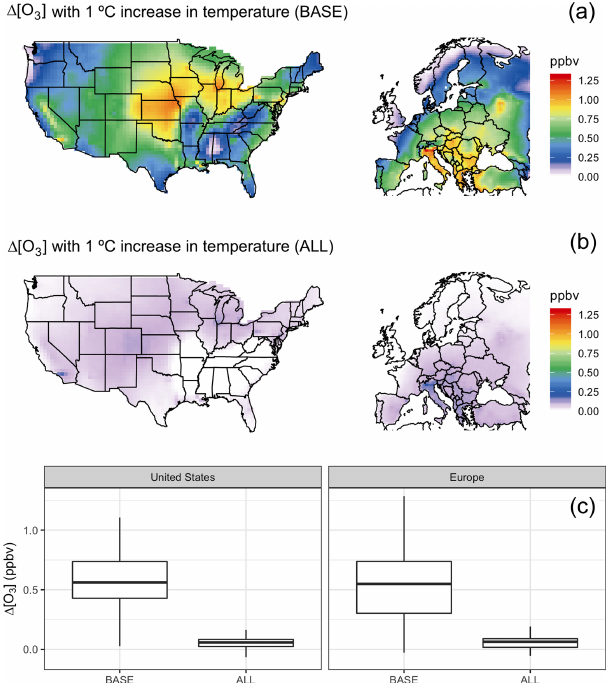
Figure 3. Increase in O 3 with a 1 ◦ C increase in temperature in the BASE case (a) and with fixed temperature mechanisms in the ALL case (b) . Distribution of changes for each shown in boxplots (c)